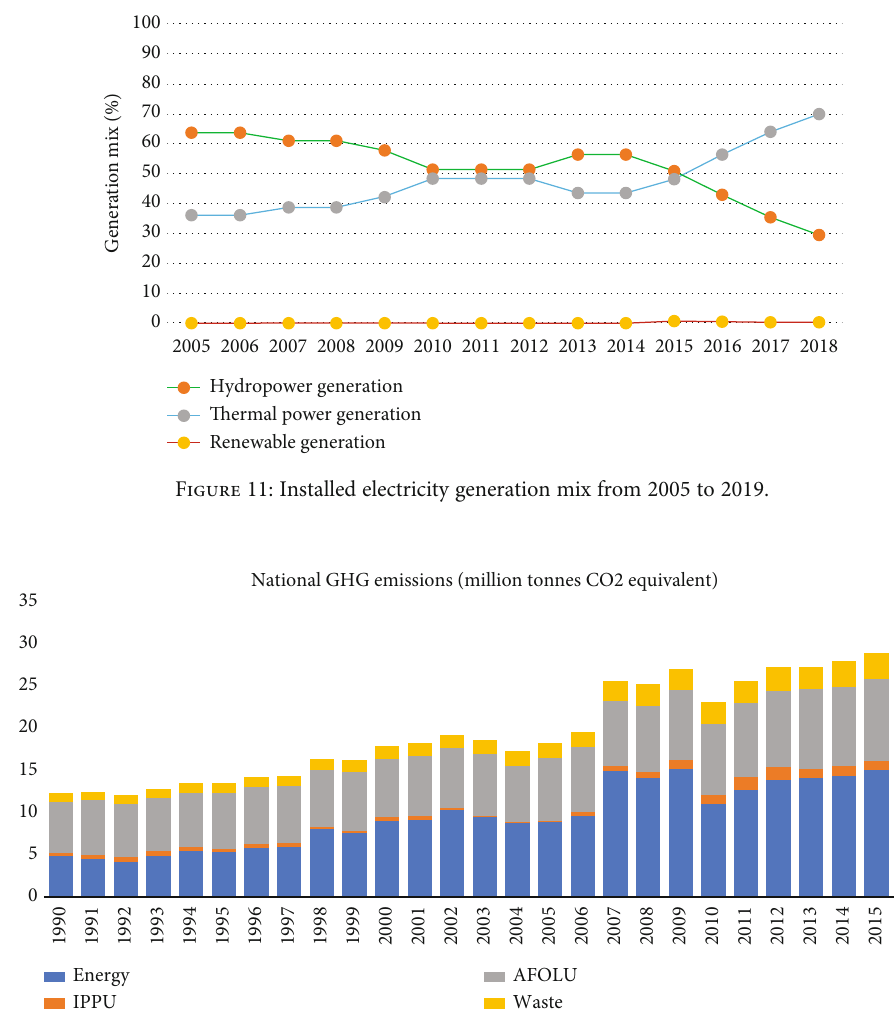
Figure 12: Contribution of GHG emissions from four economic sectors [42].